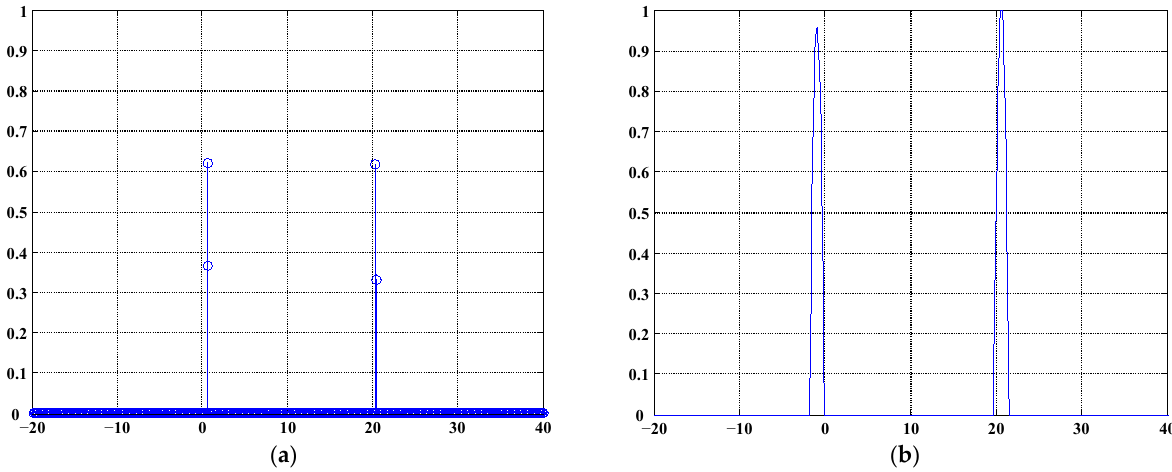
Figure 7. Simulation results. ( a ) Multi-look compressive sensing method; ( b ) Separable approximate sparse reconstruction algorithm. The horizontal axes are heights in elevation direction with the unit m, and the vertical axes are normalized amplitudes.